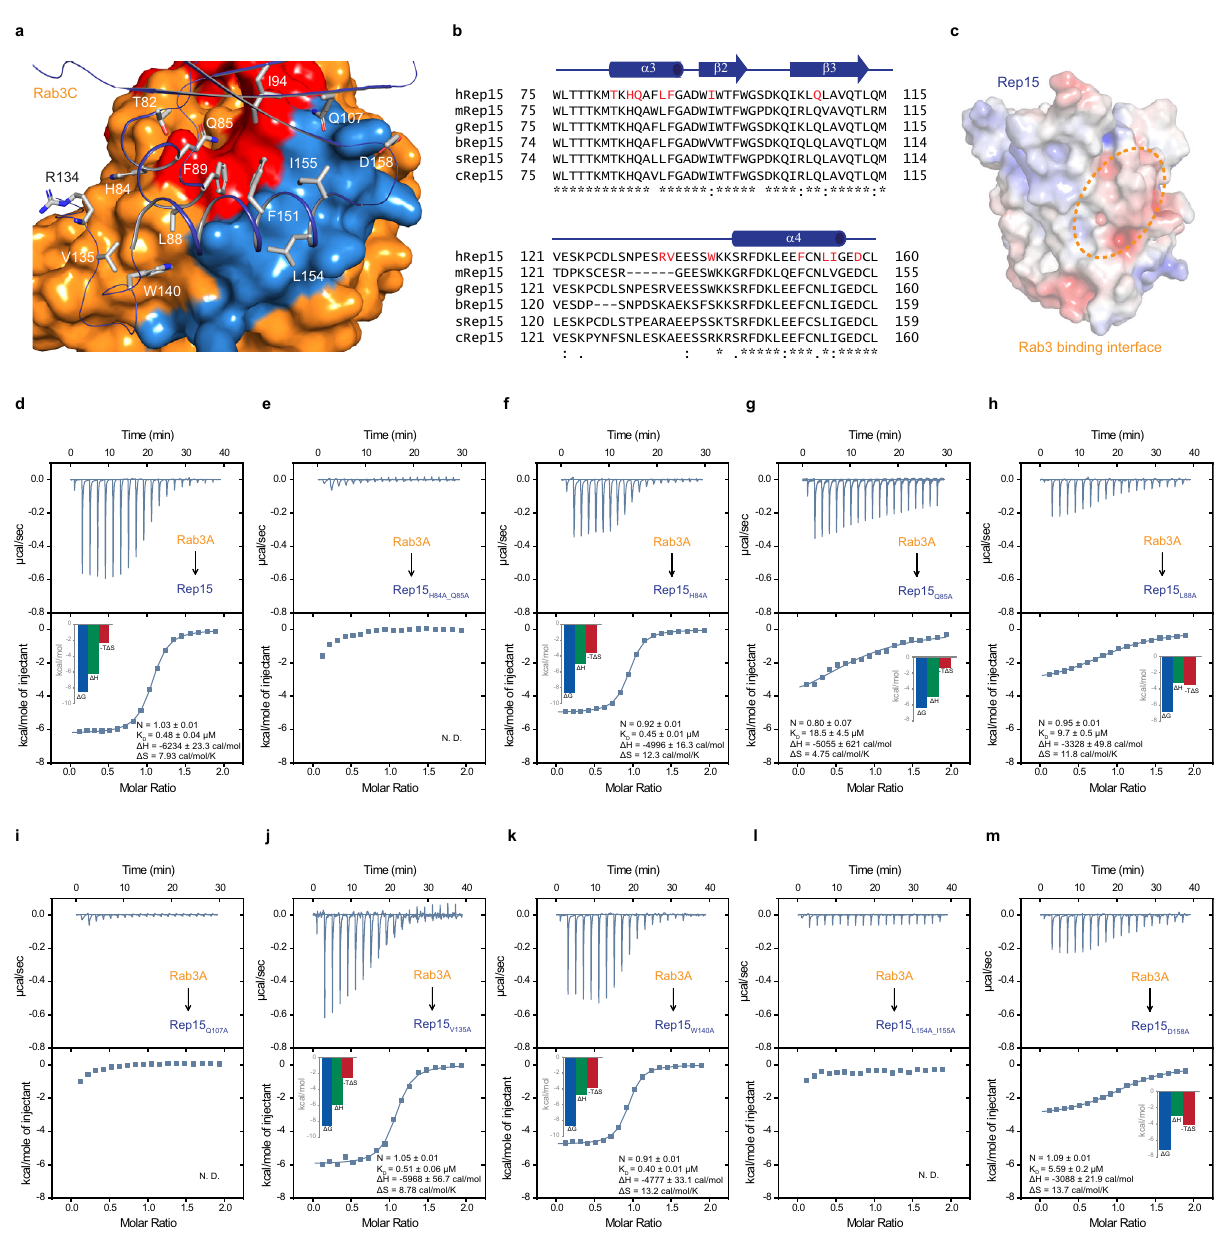
Fig. 5 Crucial Rep15 interface residues for Rab interaction. a Zoomed in the overview of Rep15:Rab3C GppNHp_Q222H_10-227 binding interface. Key Rep15 residues involved in the interaction with Rep15 are shown as sticks and labeled. Rab3C GppNHp interaction interface is shown as surface representation. Switch I and switch II regions are shown in red and sky blue, respectively. b Sequence alignment of the Rab binding site of human Rep15 along with mammalian homologs from Mus musculus (mRep15), Gorilla gorilla gorilla (gRep15), Bos taurus (bRep15), Sus scrofa (sRep15) and Canis lupus familiaris (cRep15). Residues involved in Rab3 interaction are labeled in red. c Electrostatic potential of the Rep15 calculated in PyMOL using the APBS-PDB2PQR plugin and visualized in red to blue ( − 5 kT/e to + 5 kT/e). The dashed line highlights the Rab3 binding interface. d – m Alanine screening of the Rab binding interface residues of Rep15. The binding of Rab3A GppNHp with different Rep15 mutants was systematically tested and af fi nities were determined by ITC experiments. Mutation of H84_Q85 and Q107 to alanine led to the loss of interaction. L88 which interacts with the conserved aromatic triad of Rab3C (F67, W84 and Y99), led to a defect in Rep15 interaction. Whereas in the case of L154A_I155A mutant of the Rep15 hydrophobic patch, no interaction was detected. N.D. denotes not detected. The data are representative of at least three